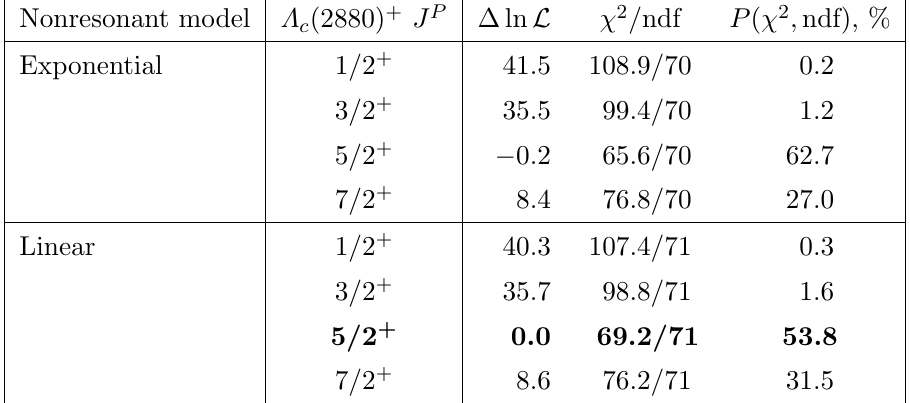
Table 3 . Values of the (cid:1) ln L and (cid:12)t quality for various (cid:3) c (2880) + spin assignments and nonreso- nant amplitude models. The baseline model is shown in bold face.